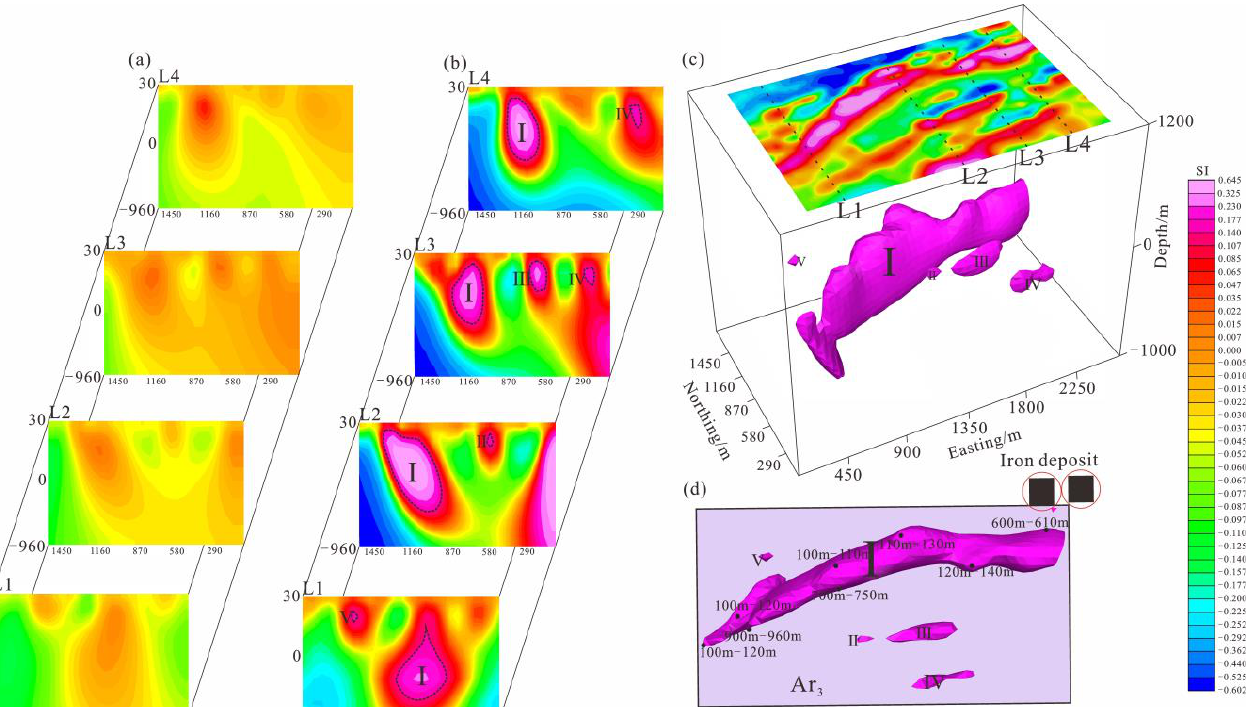
] ). ( b ) Magnetic susceptibility ; d ∆ T ; d ∆ T x y z